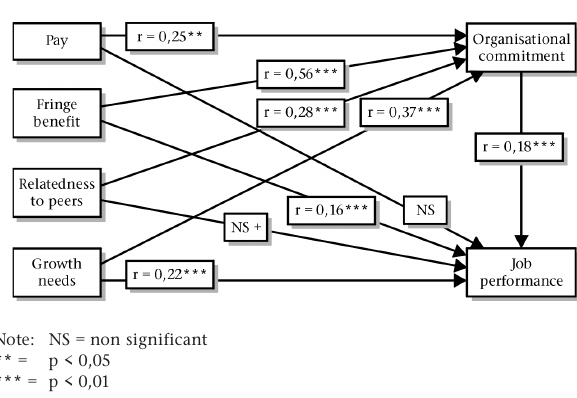
Figure 2: The empirical results: multiple regression